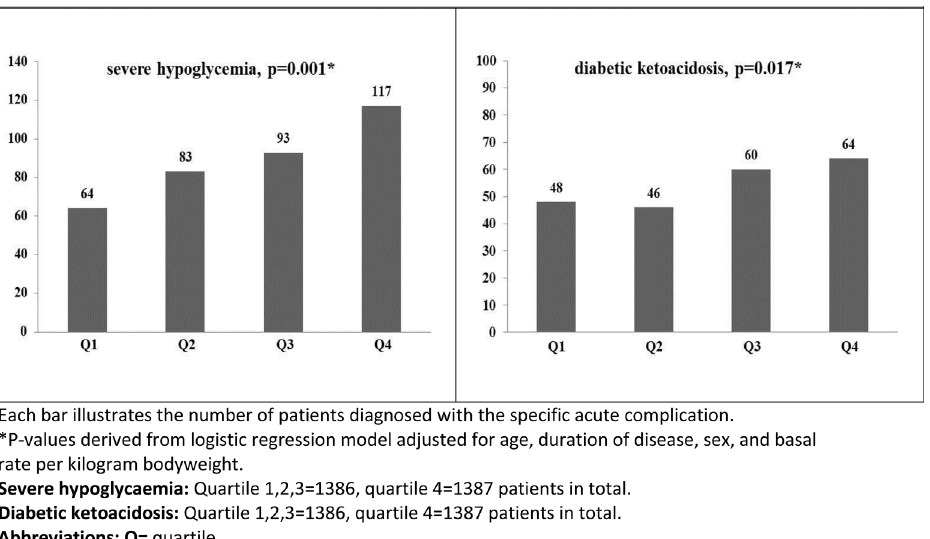
Fig 1. Bar graphs illustrating the number of acute complications per quartile of the variability